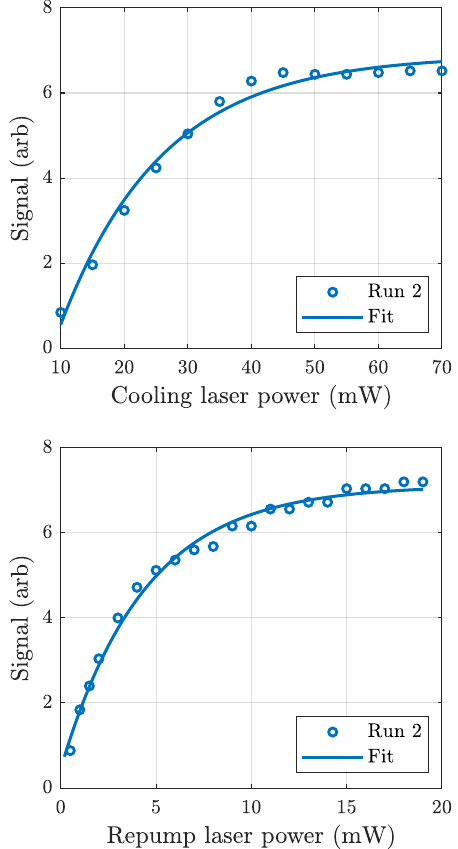
Figure A1. ( Top ) Atomic beam fluorescence vs. cooling laser power along with a fit to an exponential function; these data were used to determine the optimal cooling laser power. ( Bottom ) Atomic beam fluorescence vs. repump laser power along with a fit to an exponential function; these data were used to determine the optimal repump laser